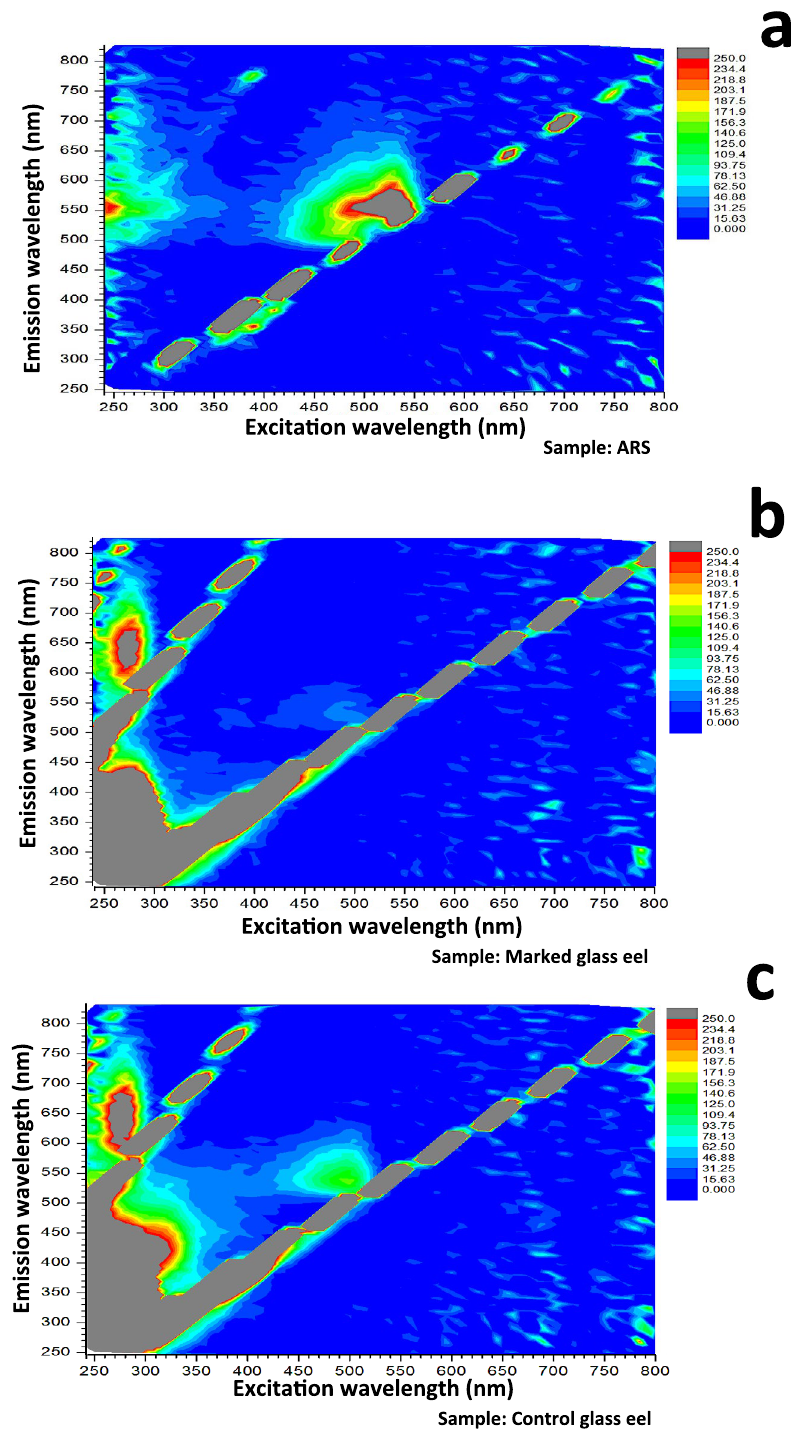
Figure 2. Excitation-Emission Matrix (EEM) fluorescence spectra. The EEM spectrum of ( a ) an alizarin red S solution (150 ppm) and as examples of EEM spectra obtained the EEM spectrum of ( b ) a marked glass eel and ( c ) a control glass eel. Fluorescence intensities are given in arbitrary units (a.